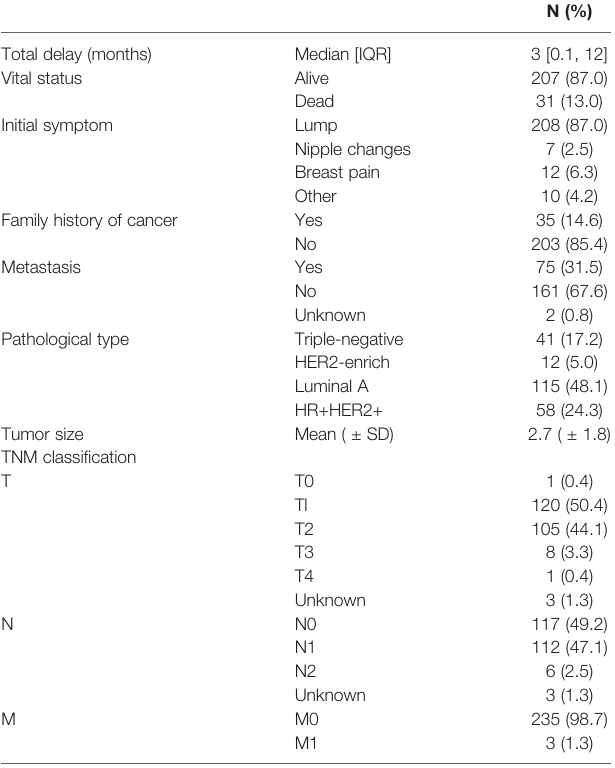
TABLE 2 | Medical history of patients (n = 239).